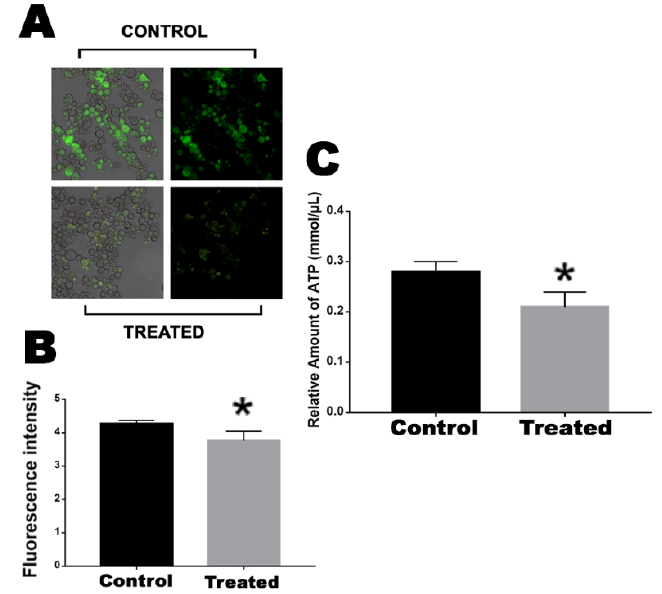
Figure 4. Evaluation of mitochondrial activity and ATP production in cells after exposure to the compound. ( A ) Fluorescence photomicrographs stained with MitoTracker Green to show the mitochondrial activity of cells after 12 h of exposure or no exposure to mebendazole. ( B ) Fluorescence intensity (in pixels) graph analyzed using the AxioVision V 4.8.2.0 software (Carl Zeiss, Dublin, CA, USA). ( C ) Quantification of ATP produced by cells that were exposed or not exposed to mebendazole. The * represents a significant difference between the samples ( p ≤ 0.05). The error bar represents the deviation between the biological triplicates.